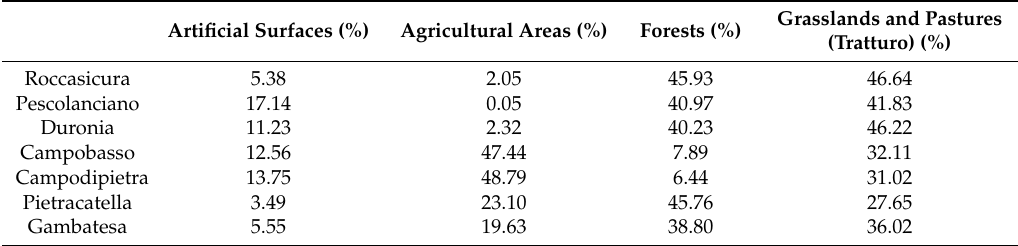
Table 6. Land use squatting classes in percentage updated to 2014; the data refer to municipalities interested by presence of hot